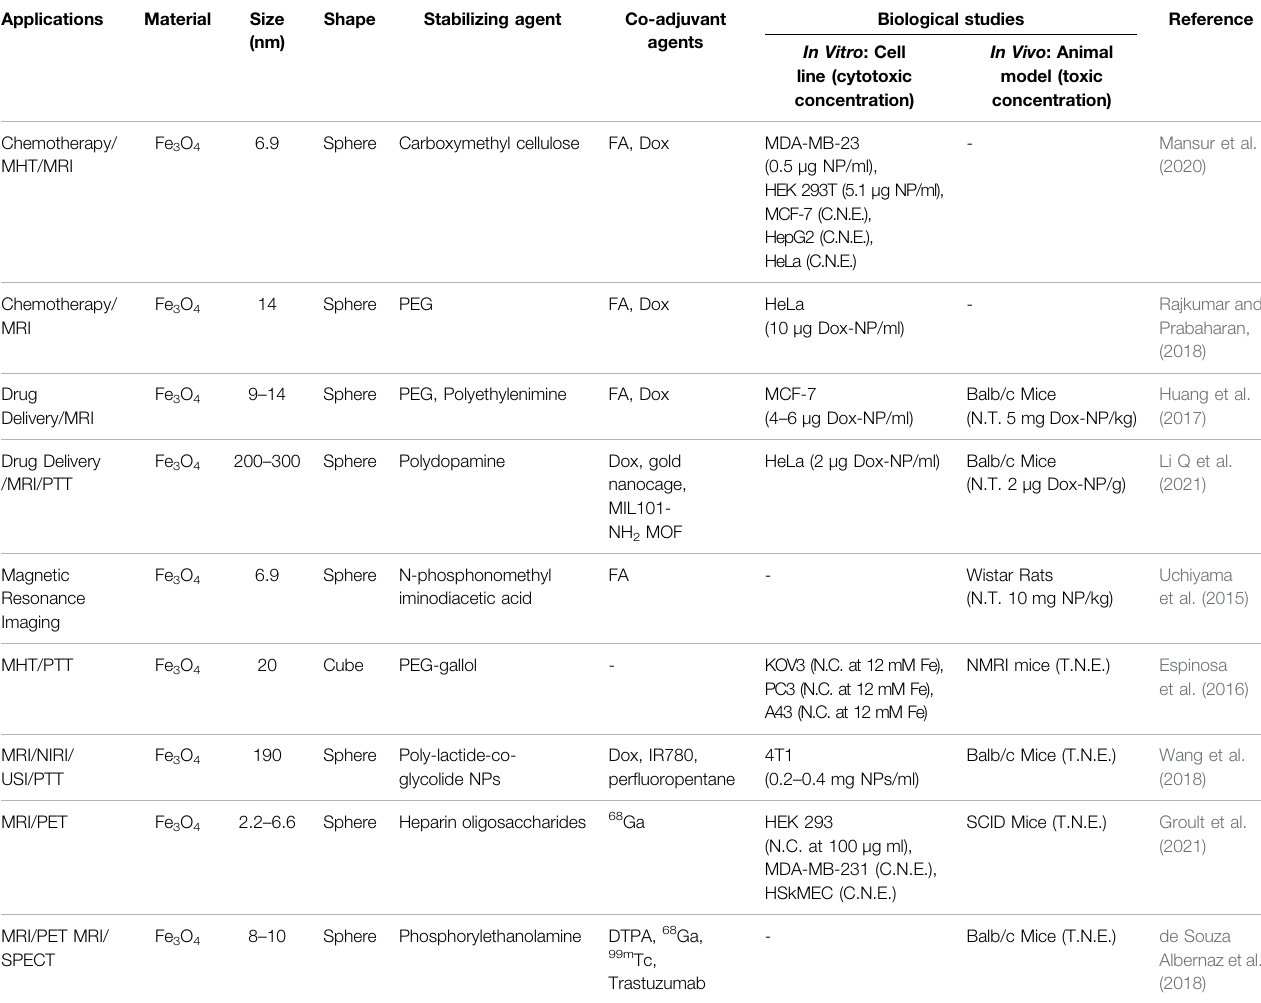
TABLE 3 | Examples of IO-based nanomaterials and its application in cancer theranostics.